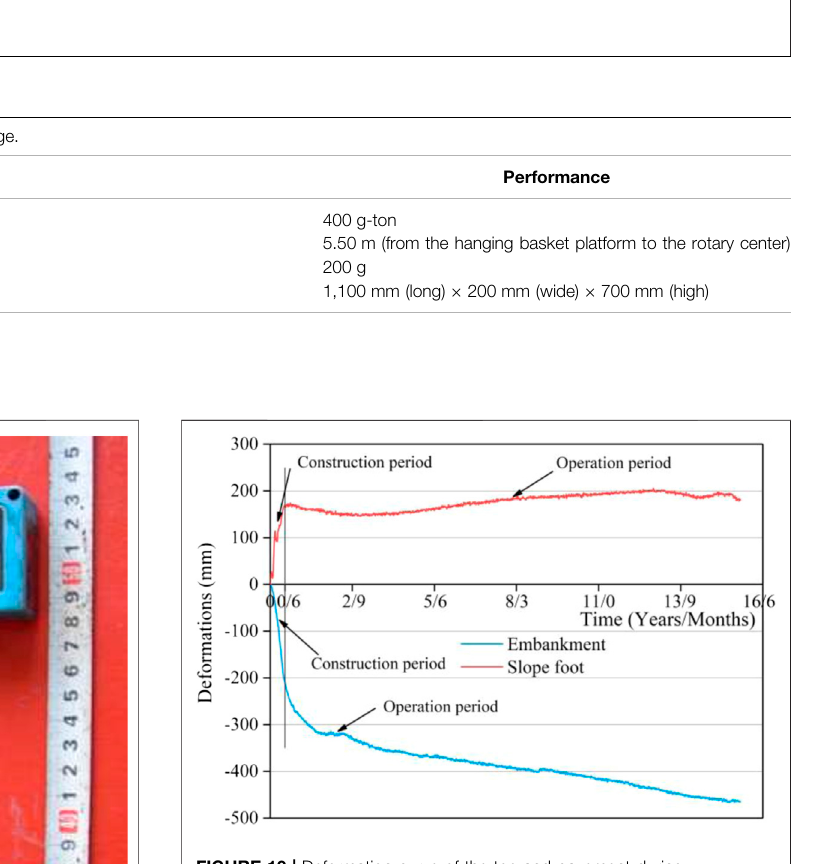
FIGURE 10 | Deformation curve of the toe and pavement during construction and